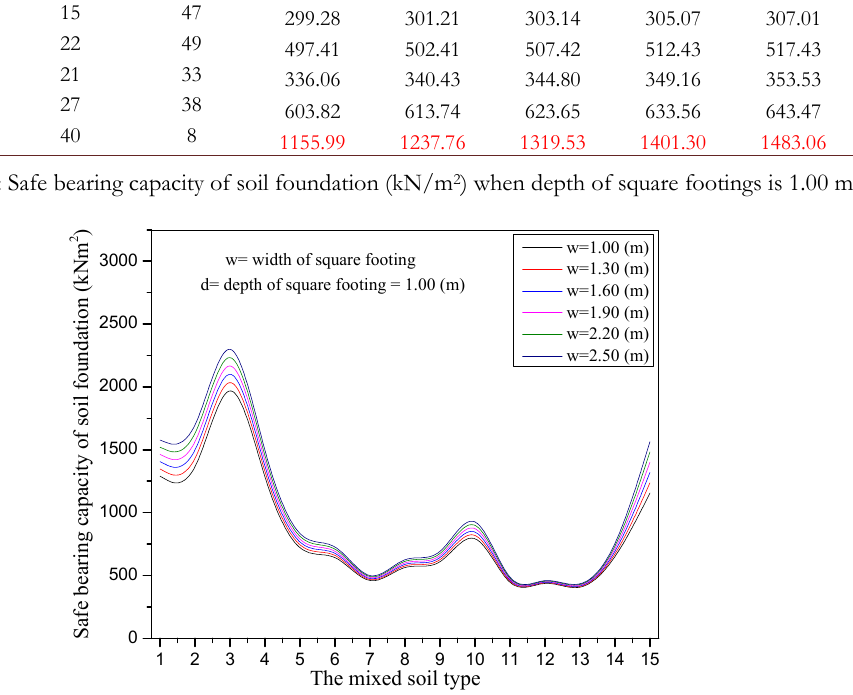
Figure 2: Safe bearing capacity of soil foundation (kN/m 2 ) Vs the mixed soil